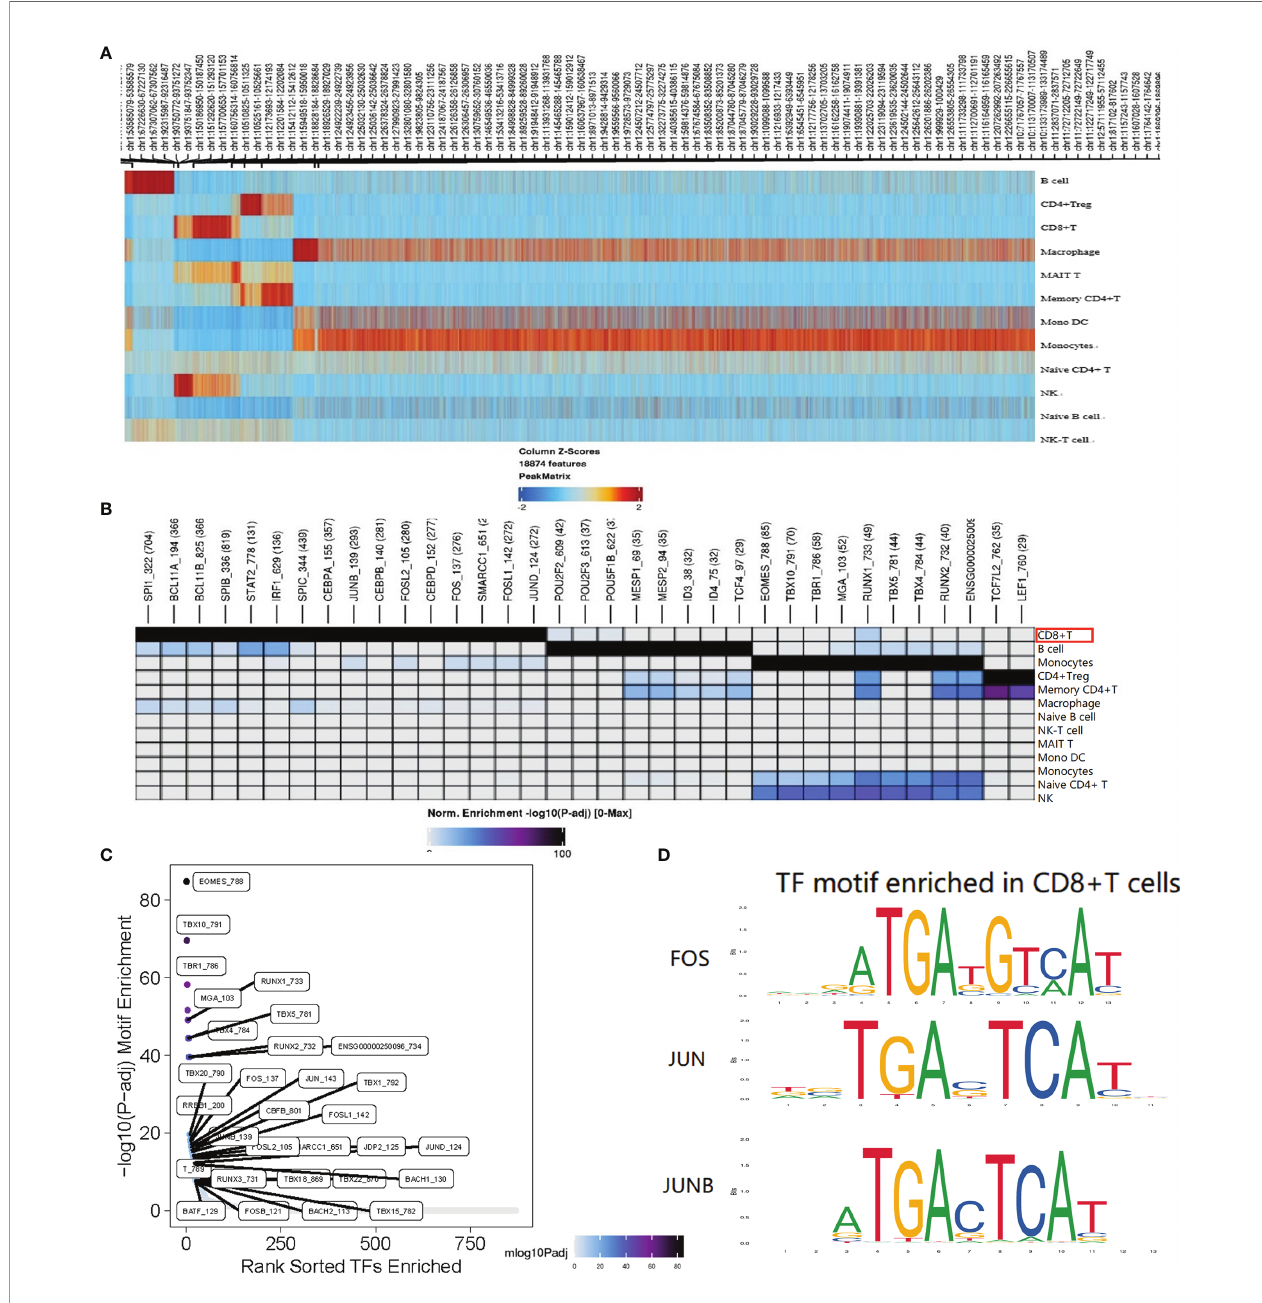
FIGURE 5 | Single-cell ATAC analysis of CD8+T cell. (A) The heatmap shows the peaks that are speci fi c for each cell type. (B) Different TF motifs in each cluster are speci fi c for each cell type (p < 0.05); The red border indicates the motif associated with genes FOS , JUN , and JUNB ; (C) CD8+T cell speci fi c motif highly enriched in the peak; (D) FOS , JUN , and JUNB with differential accessibility between the AS-PBMC and NC-PBMC libraries across CD8+T cell. P values shown in this fi gure were calculated with ArchR through the difference analysis feature and adjusted using the Benjamini – Hochberg correction for multiple